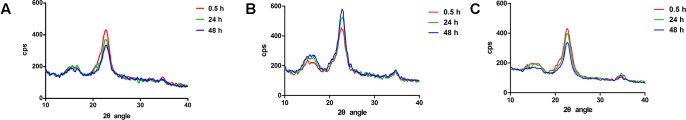
X-ray diffraction spectra of Avicel treated with wild type and Δ0125 mutant. X-ray diffraction spectra of Avicel treated with wild type (A), Δ0125 mutant (B), and C0125
(C). CIXRD (%) = (I002 - Iam)/I002 × 100%. I002 is the height of the crystalline peak at 22° and Iam is the intensity of the peak at 18°.